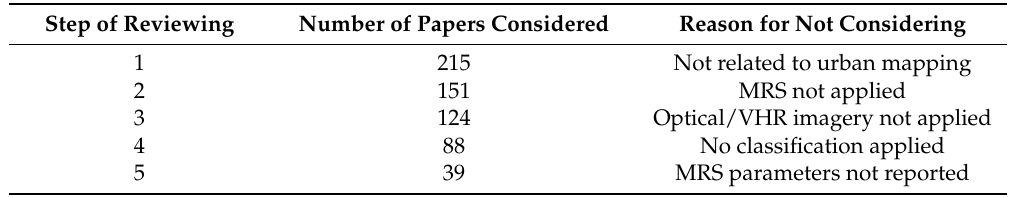
Table 3. Number of papers considered at each step of reviewing and reasons for eliminating papers in subsequent